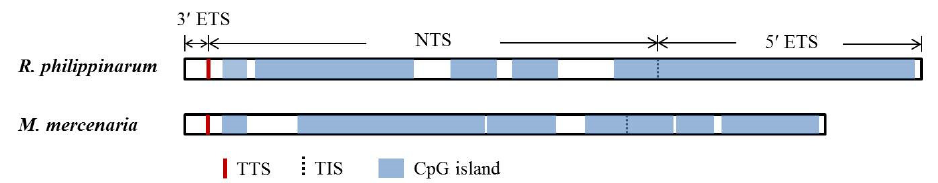
Figure 1. Structural organisation scheme of the IGS region in R. philippinarum and M. mercenaria . ETS, external transcribed spacer; NTS, non-transcribed spacer; TTS, transcription termination site; TIS, transcription initiation site; CpG island, cytosine-guanine island.